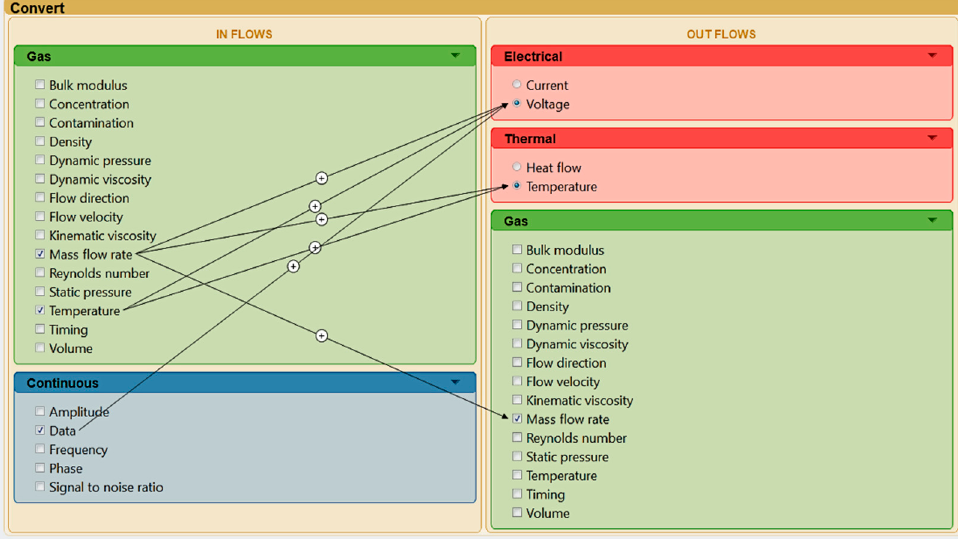
Figure 5. Functions and flows of the fuel-cell module considered.